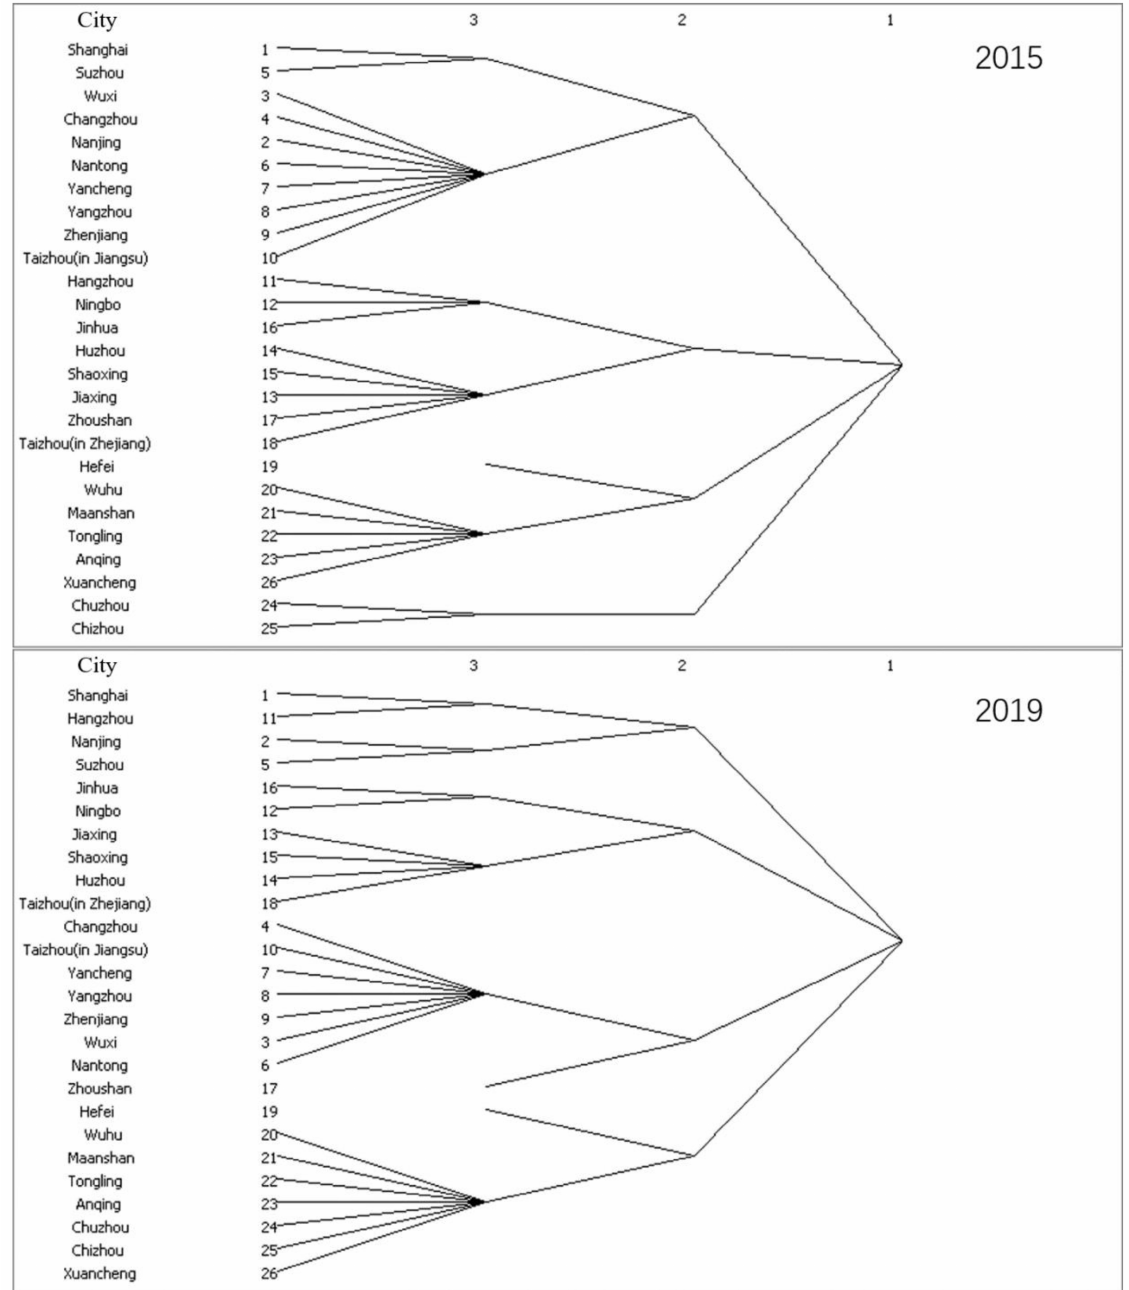
Figure 9. Cohesive